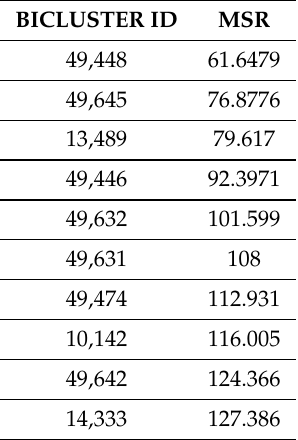
Table 1. This table shows an example of the output that gMSR generates: a ranking with the N best biclusters accoding their MSR val ues, being N = 10 in this case. Additionally, an MSR value threshold of 150 is